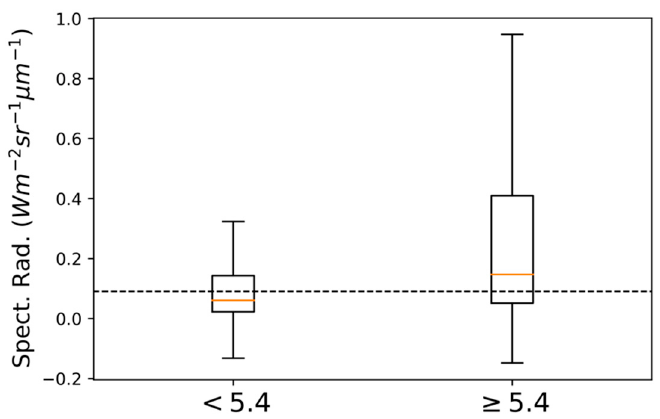
Figure A8. In red are all hotspots detected by the AHI FRP product on 25 September 2015 and in blue are all AHI SWIR pixels with a spectral radiance value >0.1 W m 2 sr − 1 µm − 1 .